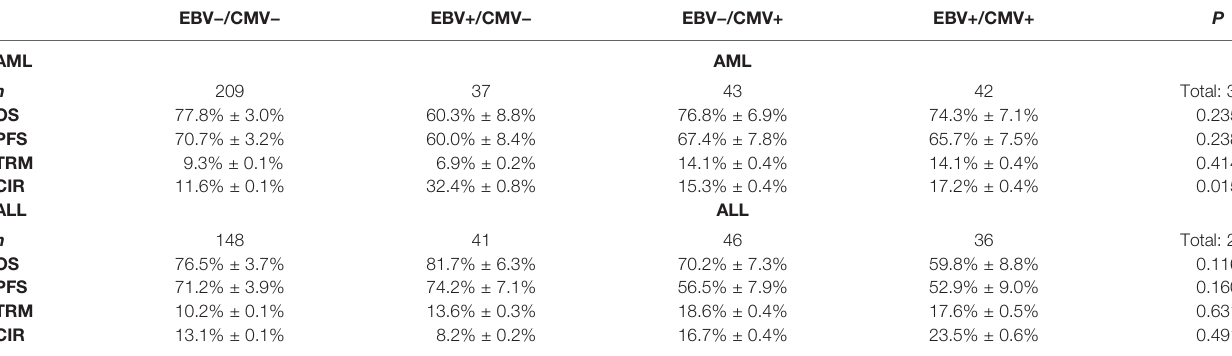
TABLE 4 | Transplant outcomes of patients among subgroups based on viral